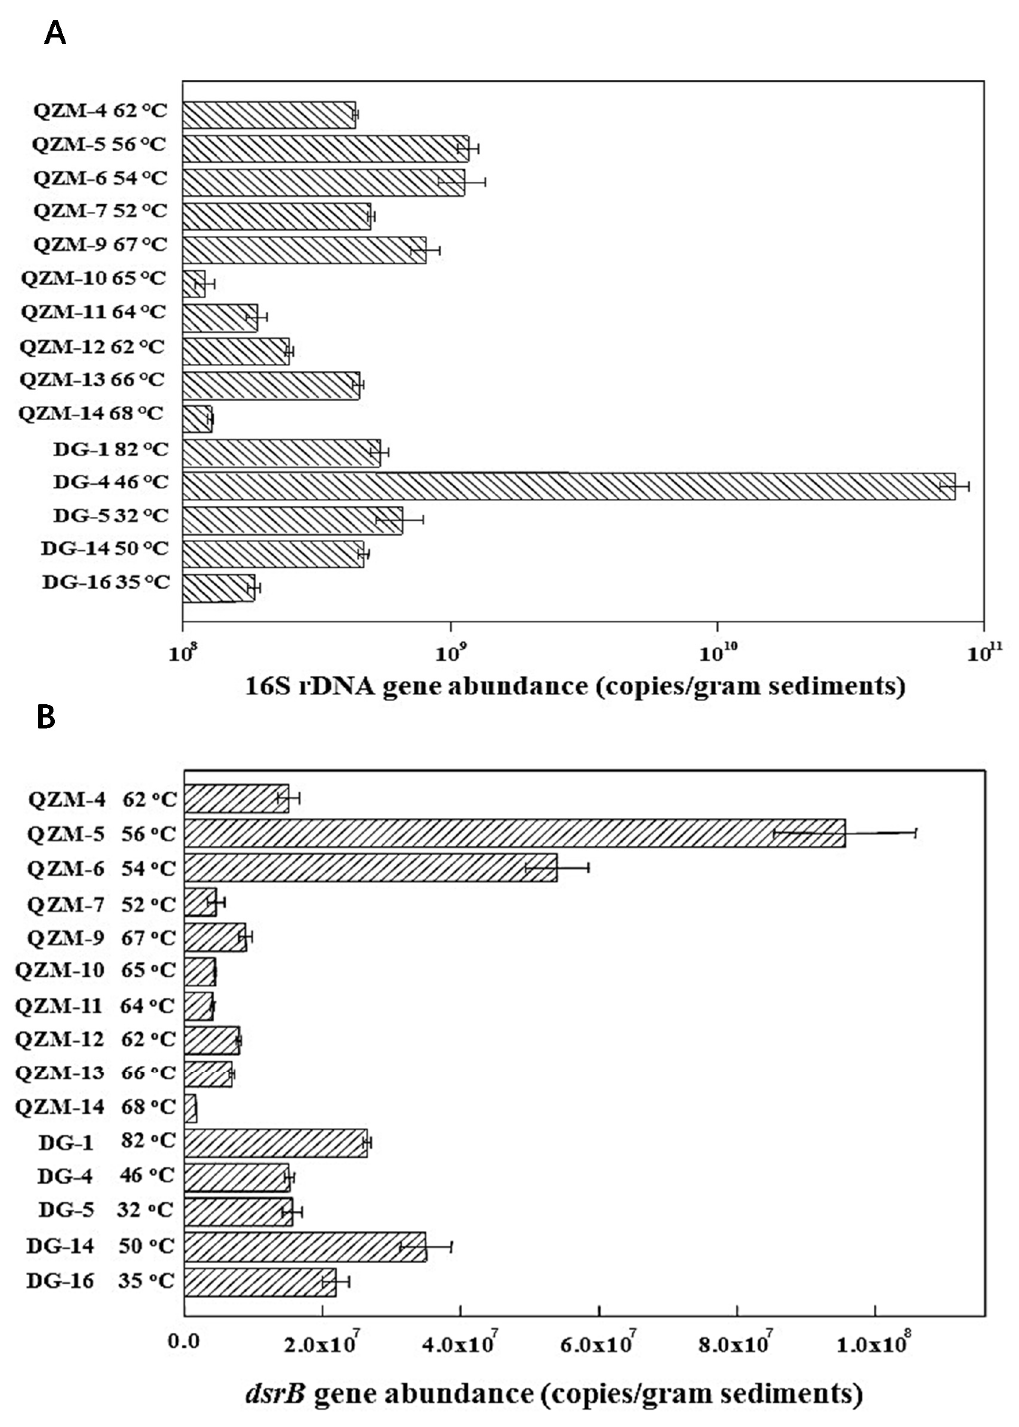
Figure 3. Bacterial 16S rRNA ( A ) and dsrB gene ( B ) abundances in the studied hot springs as detected by quantitative polymerase chain reaction (qPCR).